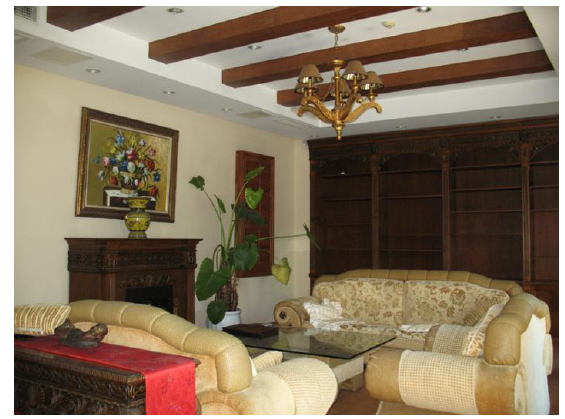
Figure 16. Family room of a Beijing Guantang courtyard garden villa, designed, built, and furnished in Western architectural style. Photo: Donia Zhang